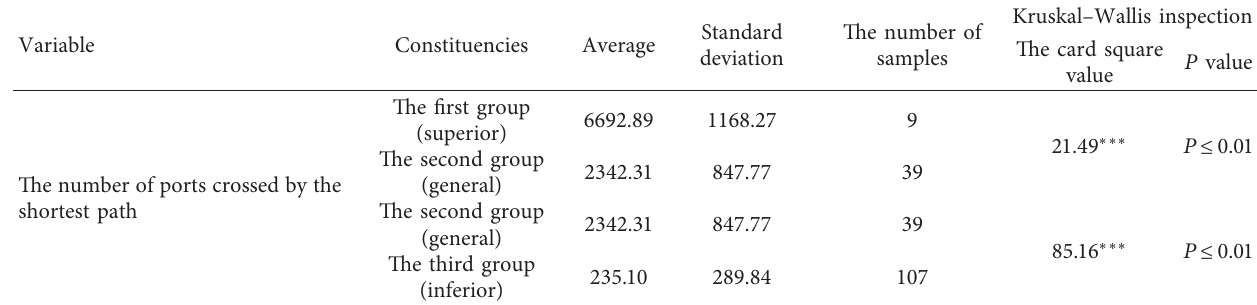
Table 4: Kruskal–Wallis test grouping